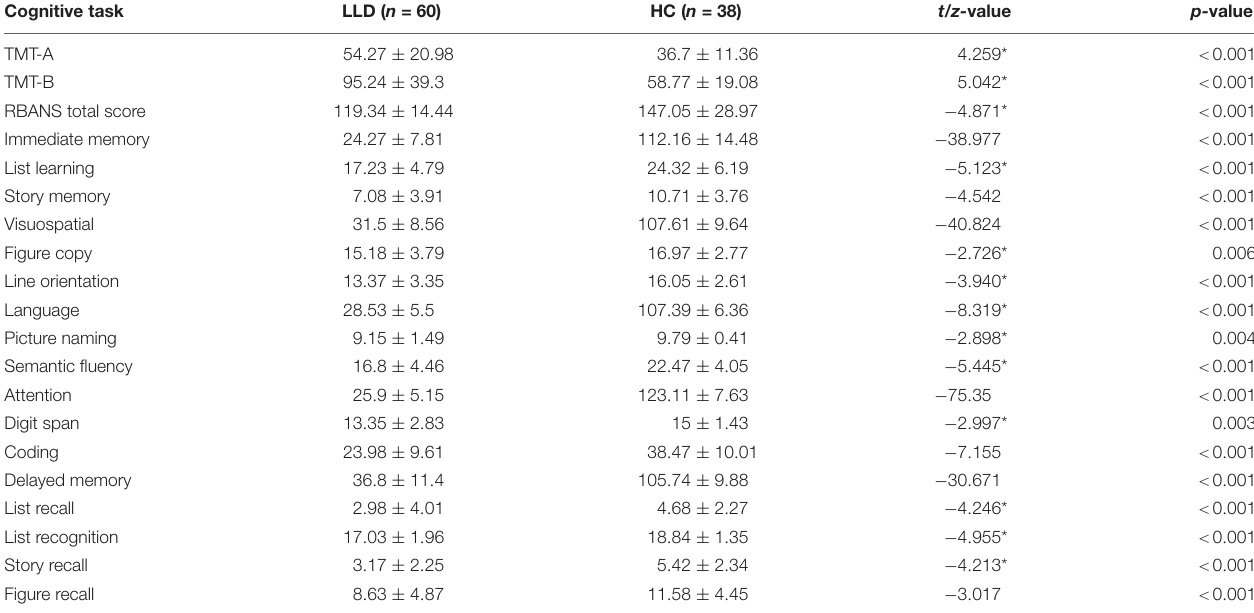
TABLE 2 | Comparison of cognitive function between LLD and HC group.